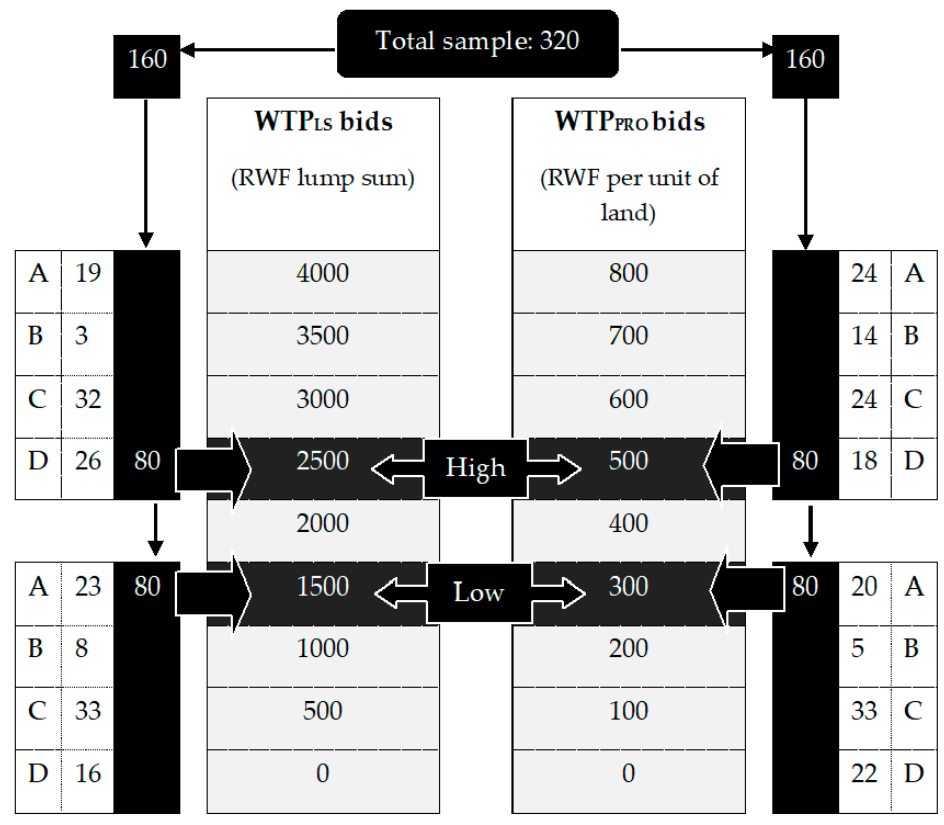
Figure 1. Bidding game design and sub-samples by cooperative